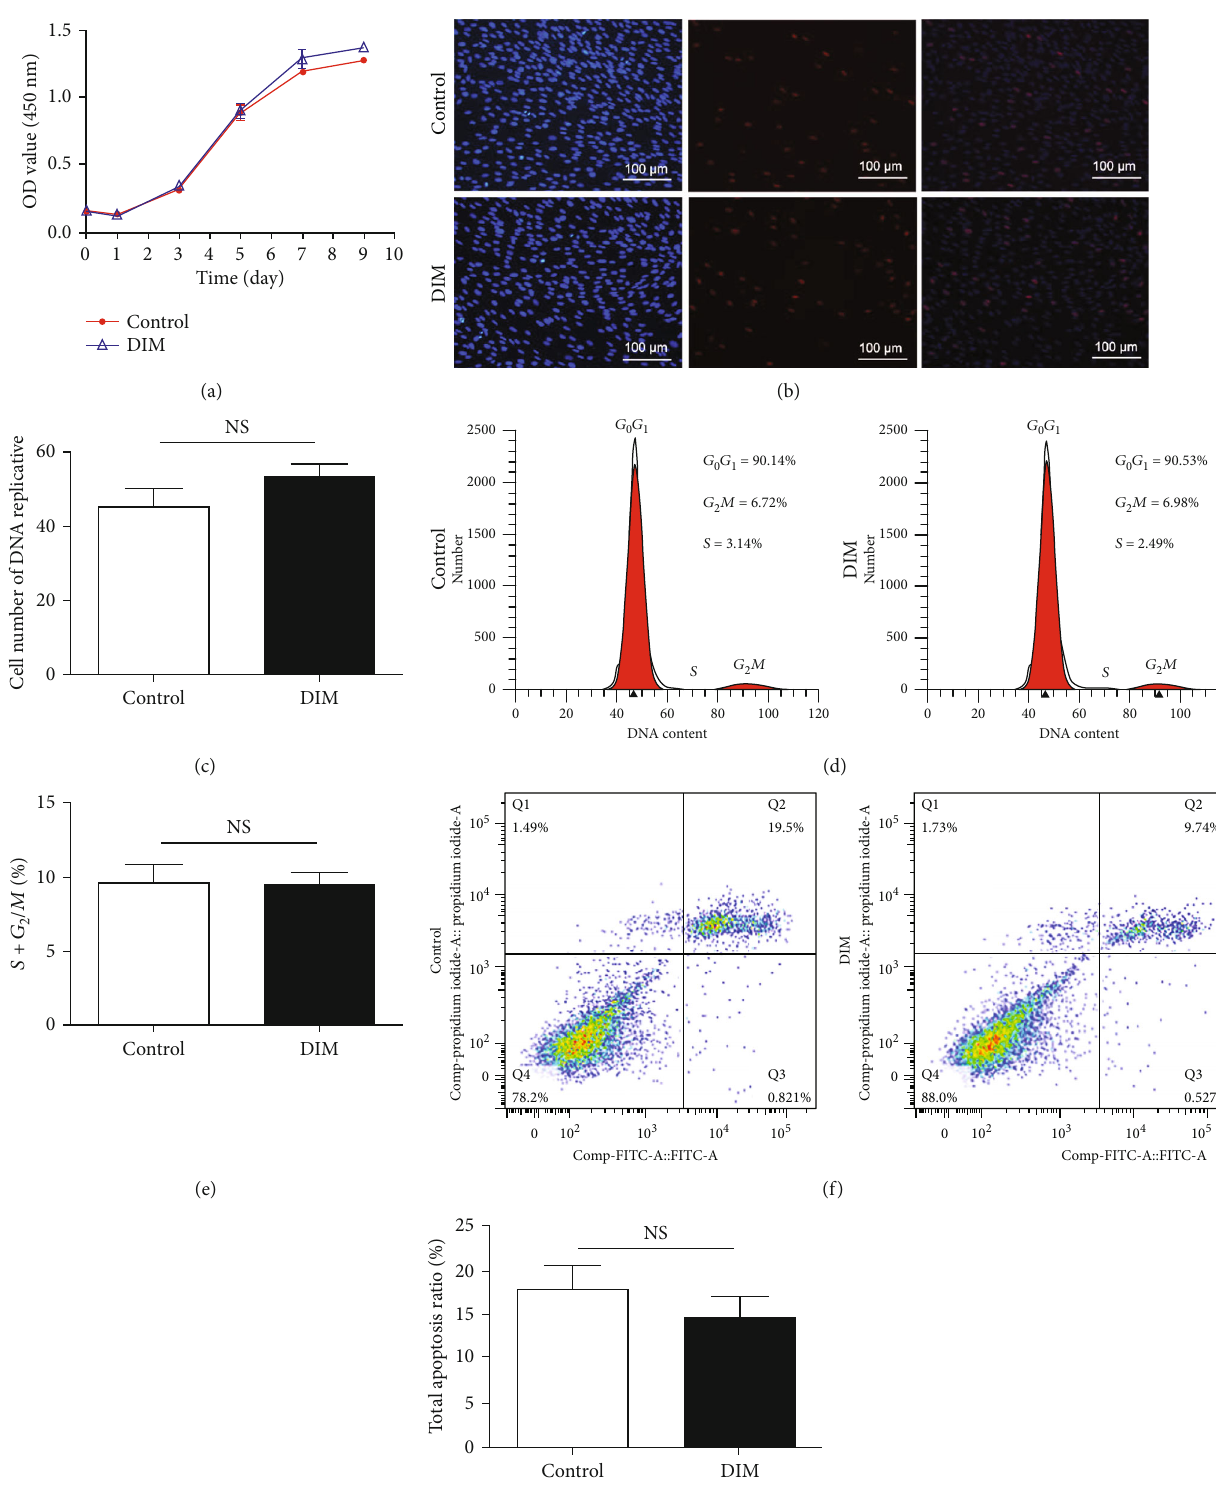
Figure 3: E ff ects of DIM on BMMSC proliferation and apoptosis. (a) CCK-8 assay was performed to measure the e ff ect of DIM on the proliferation of BMMSCs at the indicated time points. (b) EdU-positive cells under a microscope. Scale bars = 100 μ m . (c) Quanti fi cation of EdU assay. P > 0 : 05 . (d) Flow cytometry determination of proportion of BMMSCs in distinct cell cycle phases. (e) Quantitative analysis of (d). P > 0 : 05 . (f) Flow cytometry was performed to measure cell apoptosis of BMMSCs treated with DIM. (g) Quantitative analysis of (f). P > 0 : 05